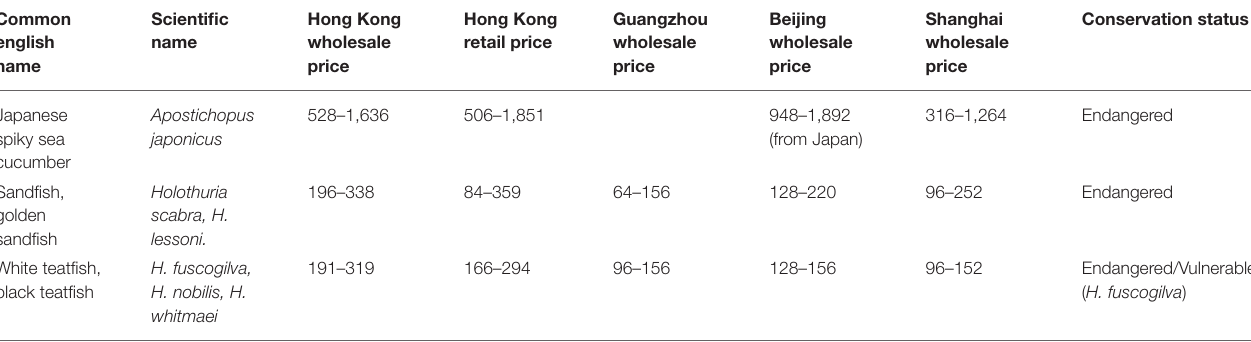
TABLE 3 | Prices of selected sea cucumbers in USD/kg, September 2015. Common